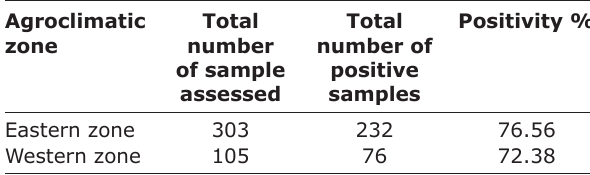
Table-3: Agroclimatic zone-wise seroprevalence of BTV in Haryana as assessed by c-ELISA in cattle species. Agroclimatic zone